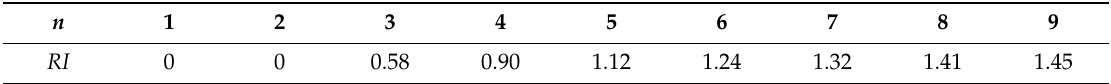
Table 2. Mean random consistency index RI